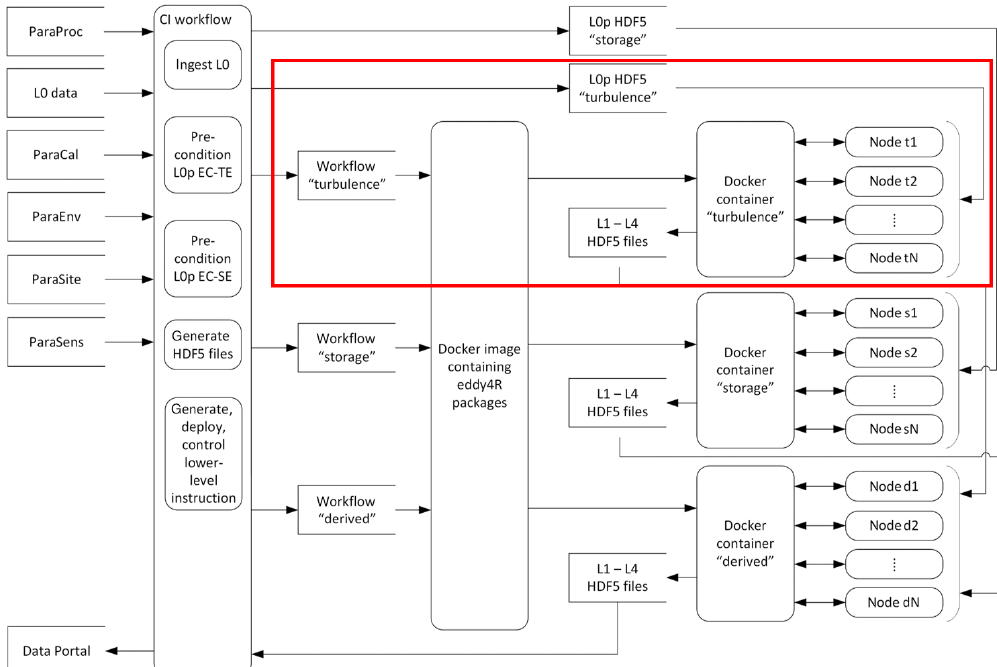
Figure 5. NEON’s eddy4R–Docker EC processing framework. The red box visualizes the scope of the present study, and individual compo- nents are described in the